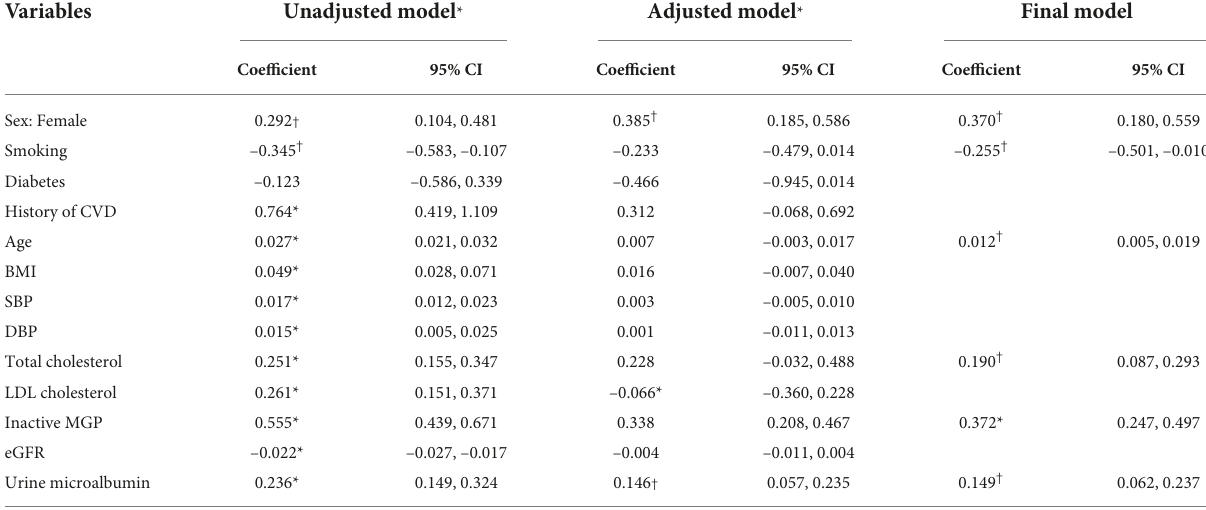
TABLE 4 Determinants of urinary matrix Gla protein